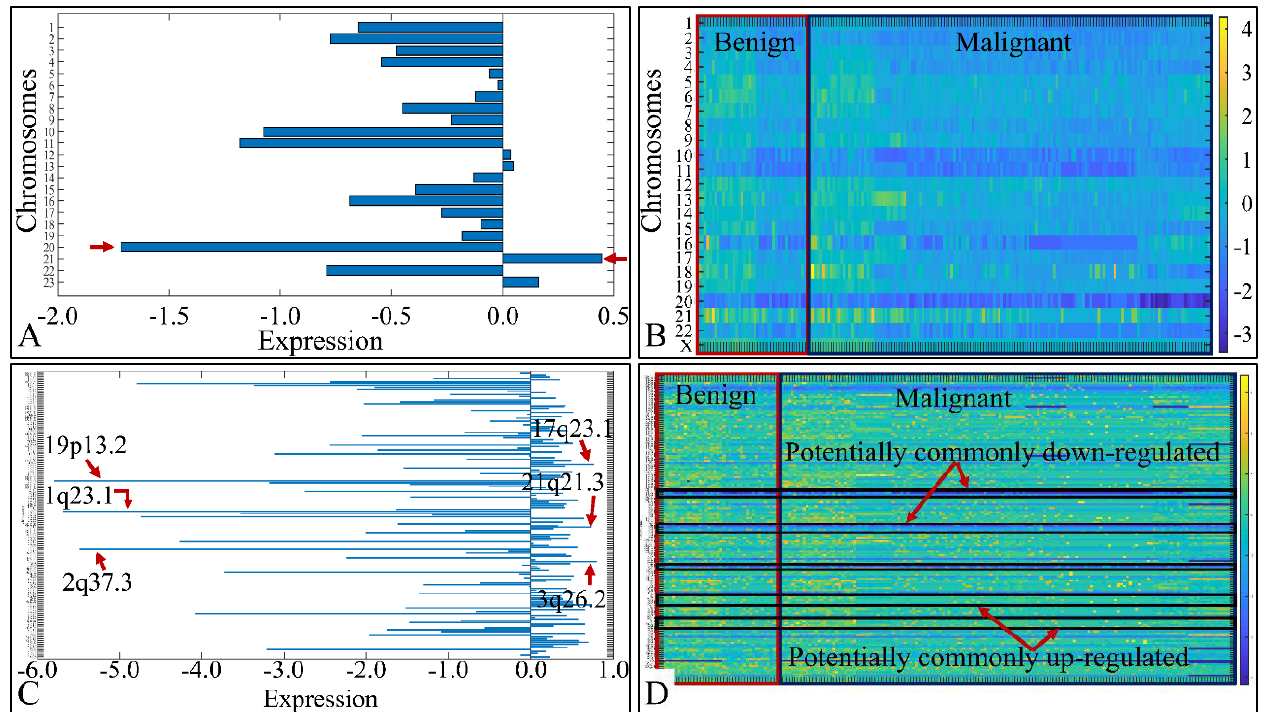
Figure 2. miRNA expression with respect to their chromosomal distribution ( A ) and location ( C ). The heat-maps depict the chromosome-related expression of the DE miRNAs ( B ), and their chromosomal location ( D ) (Legend: in sub-figure ( A ) the x -axis corresponds to miRNA expression and the y -axis to chromosome number. In sub-figure ( B ) the x -axis corresponds to tumor samples, the y -axis to chromosome number. In sub-figure ( C ) , the x -axis corresponds to miRNA expression and the y -axis to chromosomal locations. In sub-figure ( D ) the x -axis corresponds to tumor samples, the y -axis to chromosomal locations and the z -axis (the heat-map) to miRNA expression).